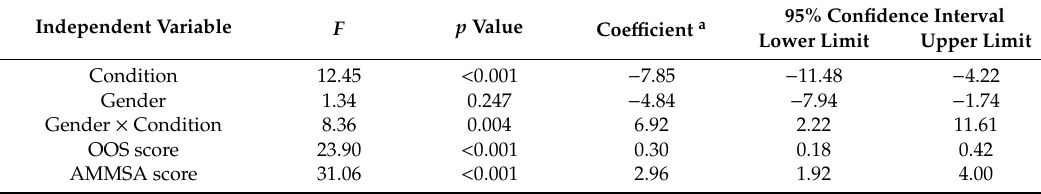
Table 3. Influences on the proportion of dwell time spent looking at the